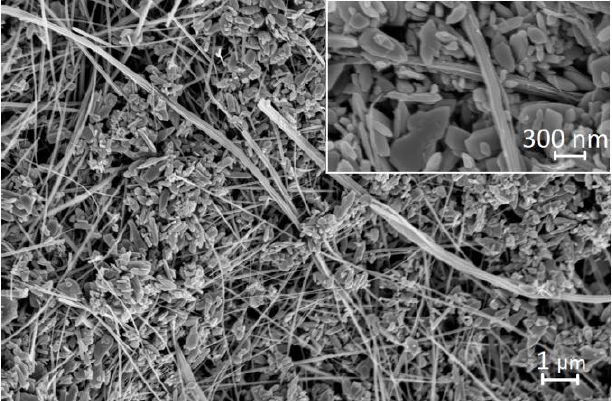
Figure 2. Field emission scanning electron microscope (FE-SEM) image of the ZnO nanostructures (magnification 20,000× and 50,000×).